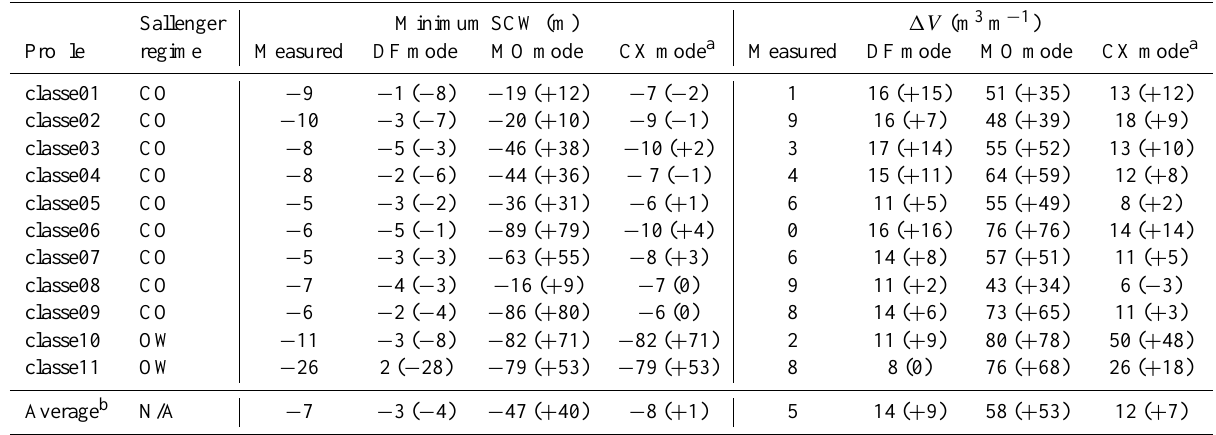
Table 2. Results of minimum safe corridor width and change in sub-aerial beach volume ( (cid:49)V ) predictions for the DF, MO and CX forecast modes. Values in brackets denote deviations from measured values. CO and OW refer to the collision and overwash regimes, according to the four dune impact regimes described by Sallenger